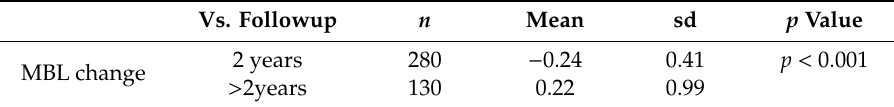
Table 6. MBL change 2 years vs. more than 2 years. sd: Standard